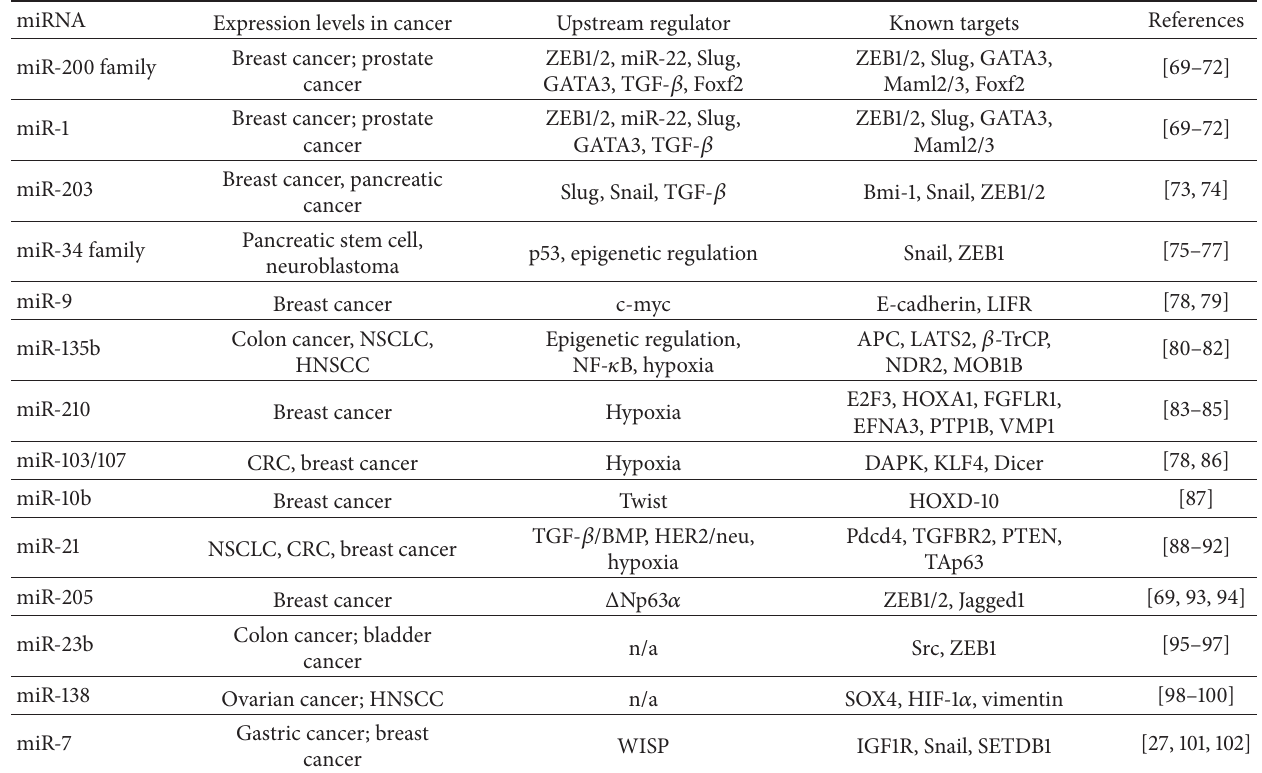
Table 1: miRNAs and other molecules involved in